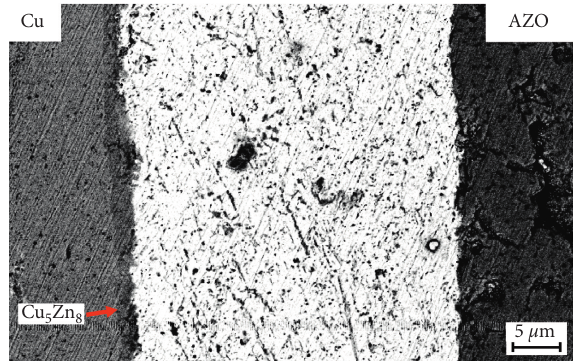
Figure 4: Cross-sectional SEM micrograph of AZO/Cu joint bonded with Sn